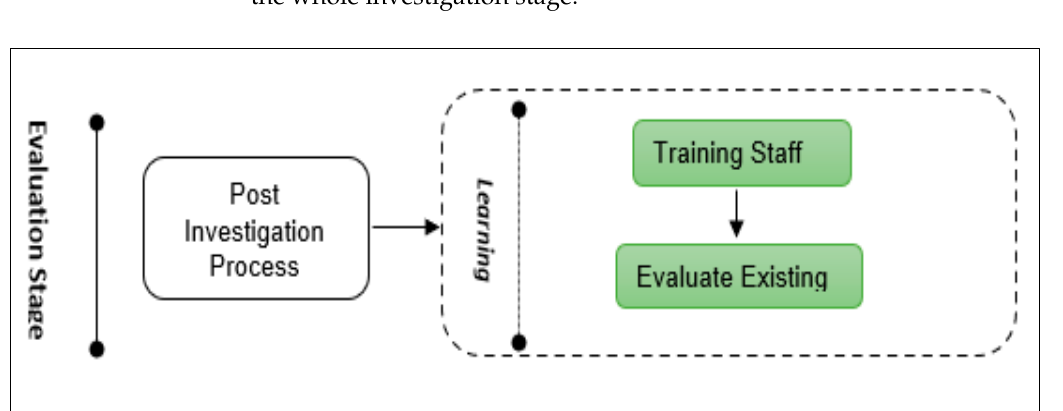
Figure 10. Evaluation Stage.